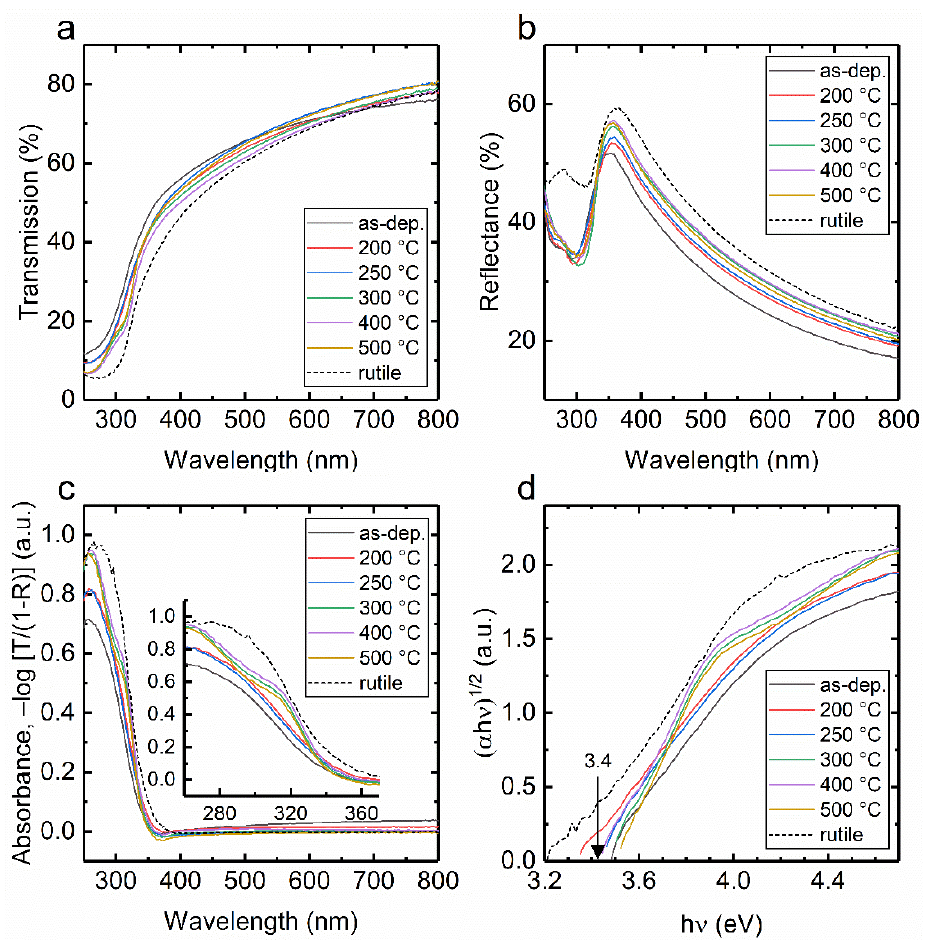
Figure 1. ( a ) Transmittance spectra, ( b ) reflectance spectra, ( c ) absorbance spectra and ( d ) Tauc plots of the ALD TiO 2 thin films grown at 150 °C and heat treated at different temperatures indicated in the plots. The spectra of a rutile thin film of equal thickness is show as dotted lines using the data acquired from Ref. [18].